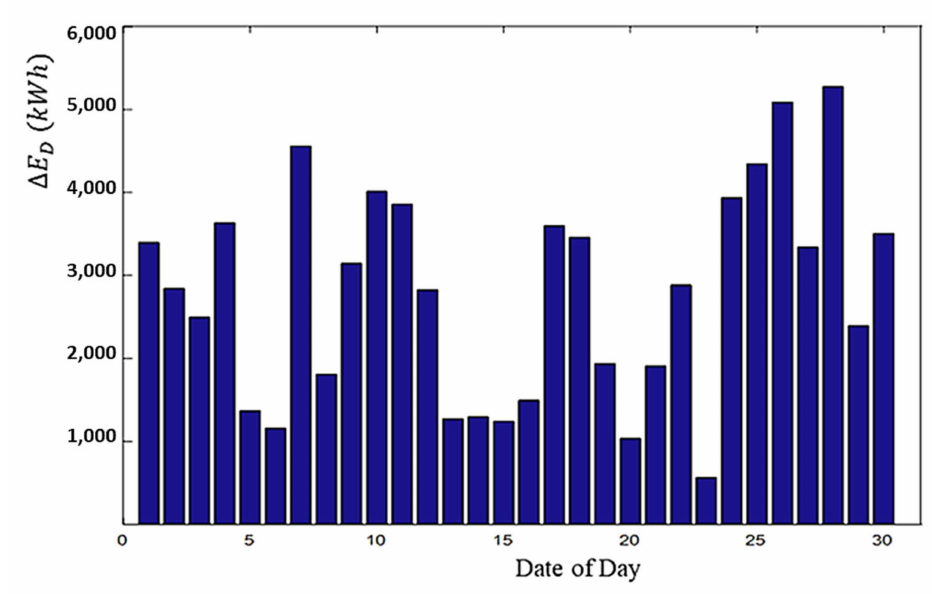
Figure 26. Evolution of the energy to be stored day-to-day for the month of August